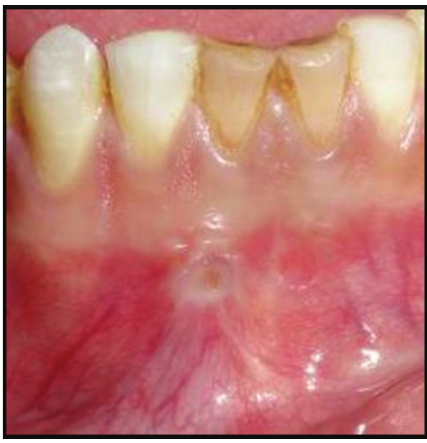
Figure 1: Sinus opening on the labial aspect of Mandibular right central incisors.